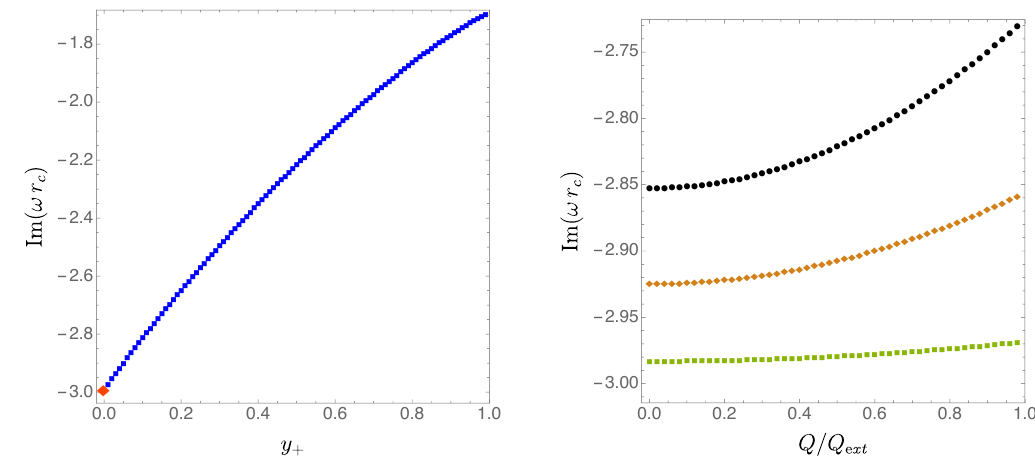
Figure 4 . de Sitter gravitoelectromagnetic mode (cid:8) (cid:0) with ‘ = 2 and n = 0. Left panel: de Sitter frequency Im( ! r c ) as a function of y + at (cid:12)xed Q=Q ext = 0 : 5. The red diamond at y + = 0 is the analytical de Sitter gravitational quasinormal mode frequency ! r c = (cid:0) 3 i . Right panel: imaginary part of the frequency as a function of Q=Q ext for (cid:12)xed y + = 0 : 01 (green squares), y + = 0 : 05 (brown diamonds) and y + = 0 : 1 (black disks).